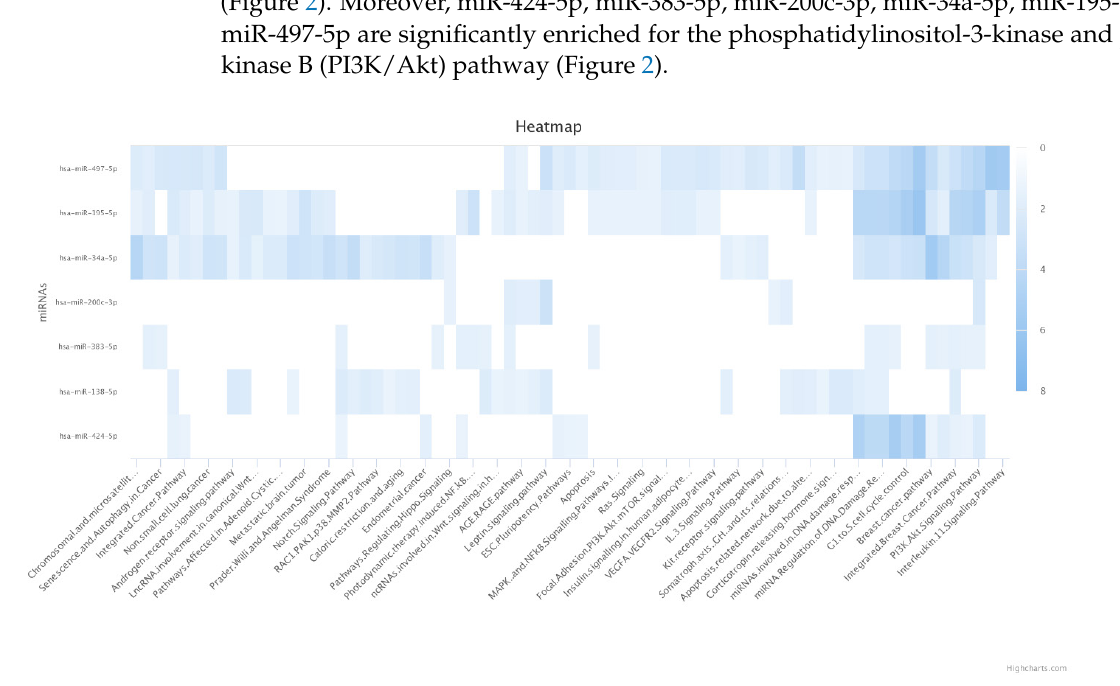
Figure 2. Enriched WikiPathways of PD-L1-inhibiting miRs. The darker color indicates a more significant enrichment.